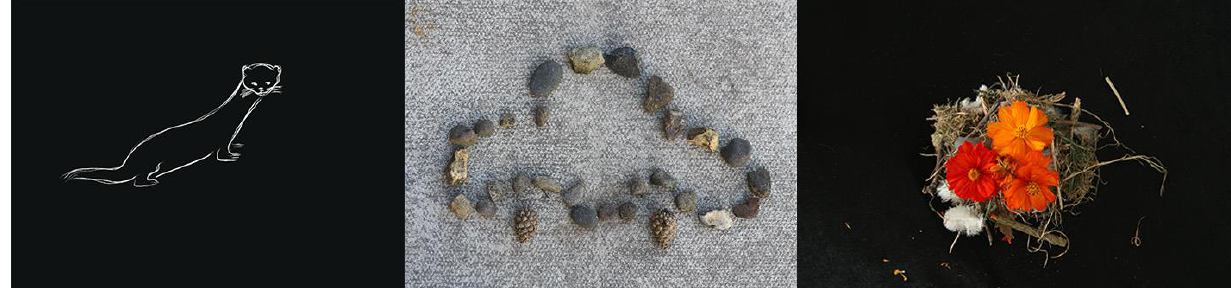
Figure 3. Captures of participants’ animations: a drawn stoat, a car, an abstract fire using flowers. The six stories : Three stories belong to the volunteers and three to the members of the support staff whose roles are referred to in brackets as (v) and (s), respectively.